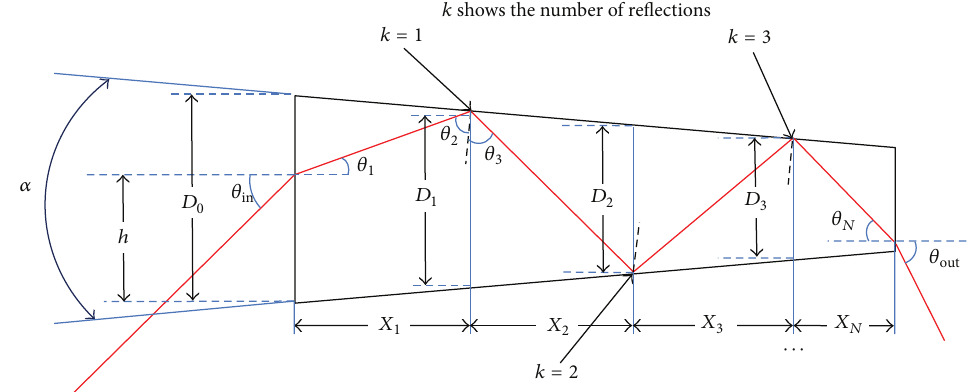
Figure 6: CTPC with total internal reflection and the dimensions of reflection